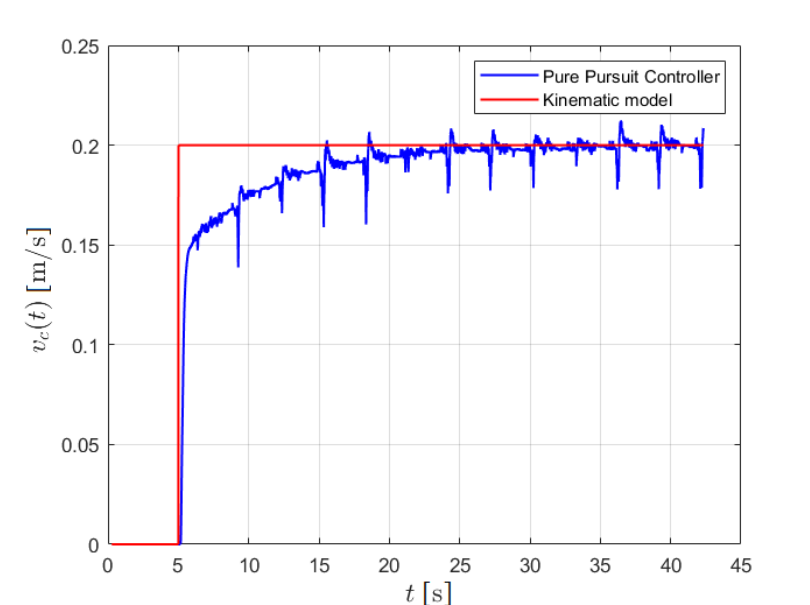
Figure 19. Linear velocity v c ( t ) of the robot.